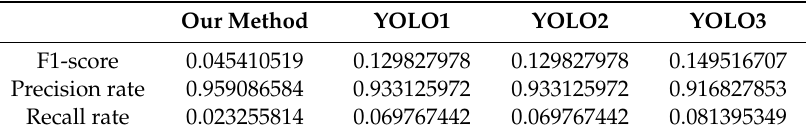
Table 10. F1-score, precision rate, recall rate of testing